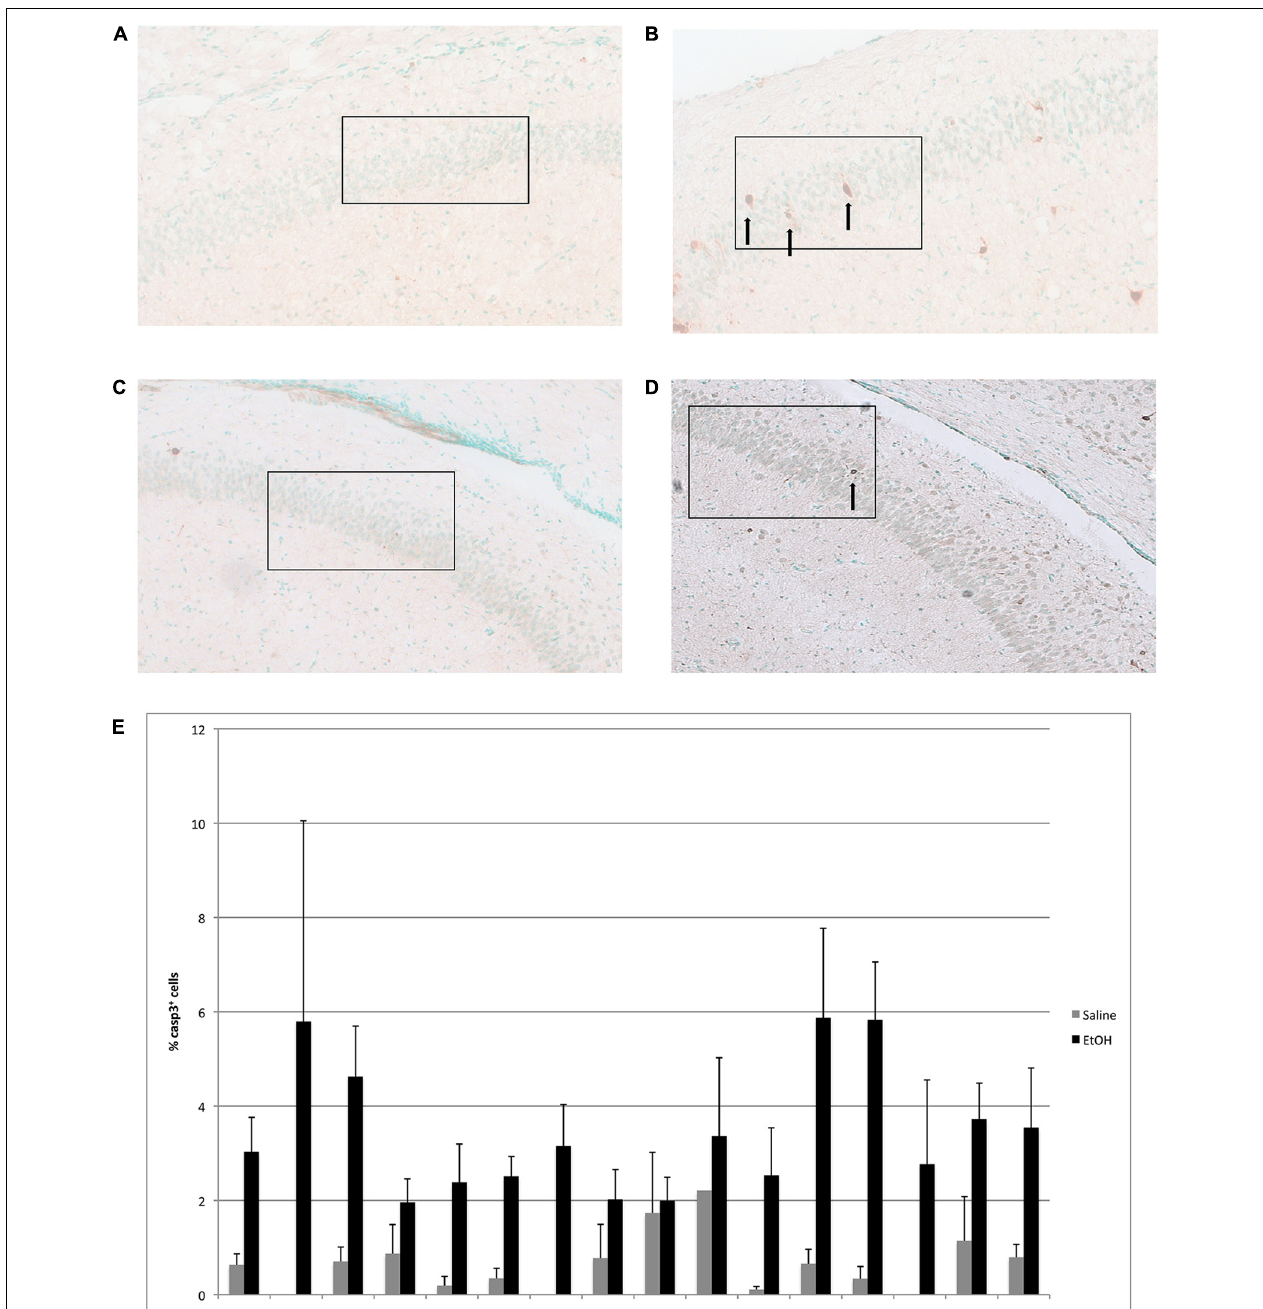
FIGURE 2 | (A) Cell death is shown in the CA1 region of resistant (BXD20) and (B) relatively susceptible (BXD96) strains. (C,D) Saline controls for BXD20 and BXD96, respectively. Boxes indicate the areas analyzed, arrows point to dying cells. (E) Cell death in CA1 is plotted as mean + SEM.